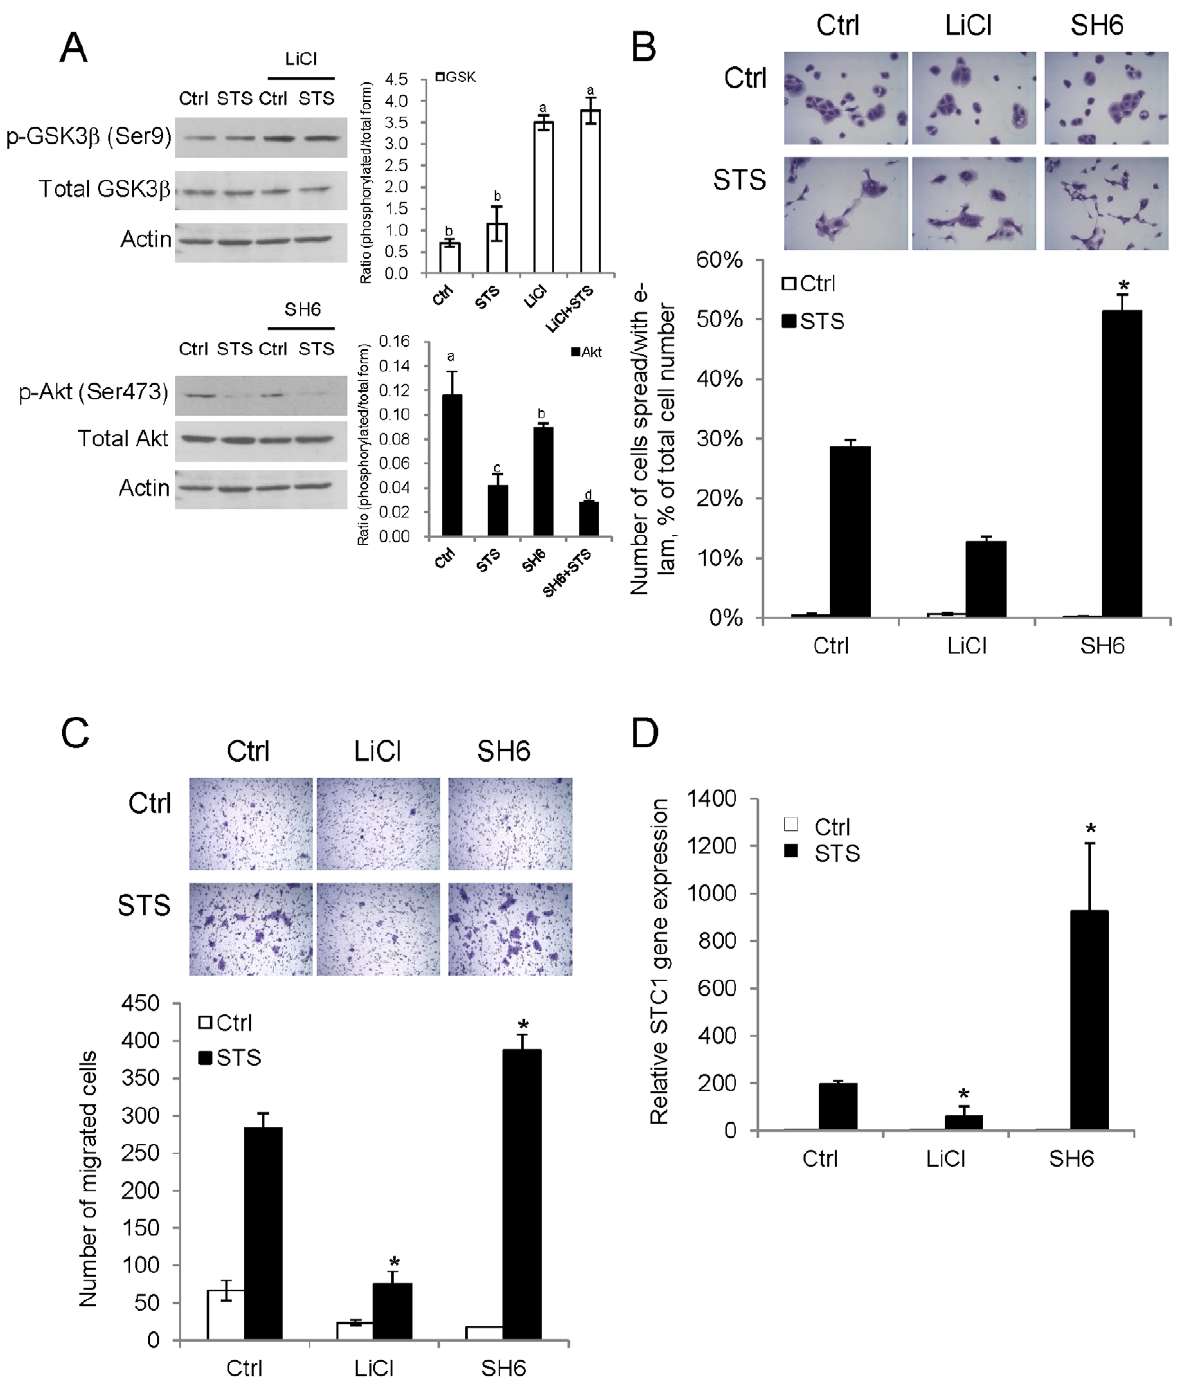
Figure 3. Akt-GSK3 b signaling mediates the keratinocyte migration process. (A) The inhibitory effects of 30 mM LiCl and 10 m M SH6 on GSK3 b and Akt-signaling respectively, were determined by probing the phosphorylated and total forms of GSK3 b and Akt. The band intensities were measured and the ratios of phosphorylated/total form were plotted. Bars with the same letter are not significantly different according to the results of one-way ANOVA followed by Duncan’s multiple range tests ( p , 0.05). STS-induced (B) e-lam formation and (C) cell migration were suppressed by LiCl but were induced by SH6. The cell images were captured under 200x and 100x magnification for e-lam formation and cell migration, respectively ( top ). (D) STS-induced STC1 mRNA expression was inhibited by LiCl, but was increased by SH6 (vs STS alone). Asterisks (*) denote p , 0.05 as compared to their corresponding control.